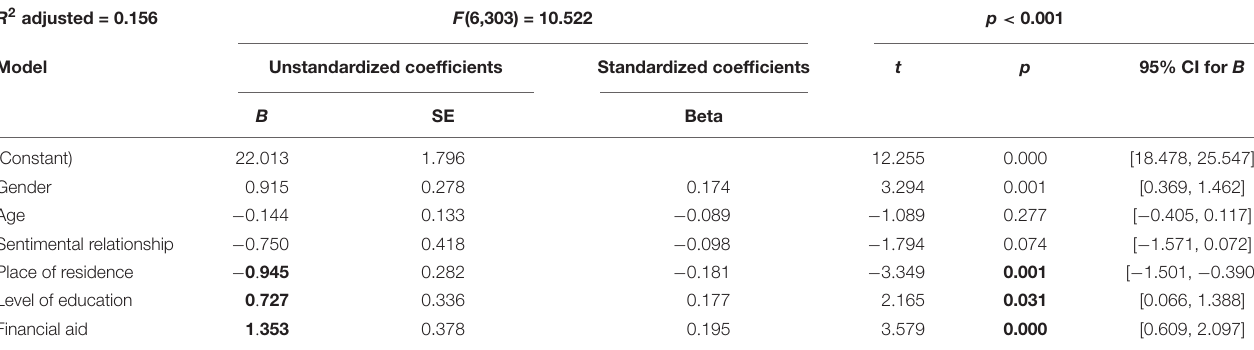
TABLE 3 | Linear regression analysis of the demographic determinants of adolescents’ “knowledge” toward COVID-19. R 2 adjusted =